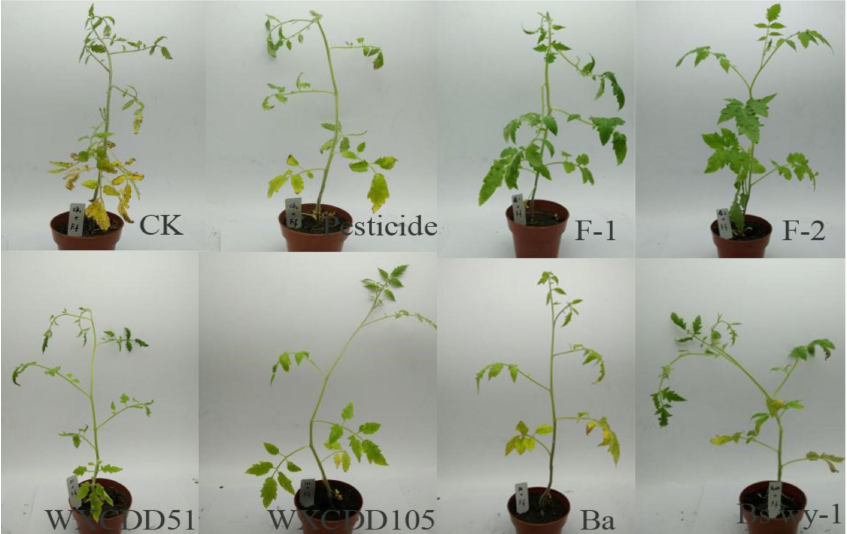
Figure 7. Therapeutic effects of single and complex strains on tomato seedlings infected with leaf